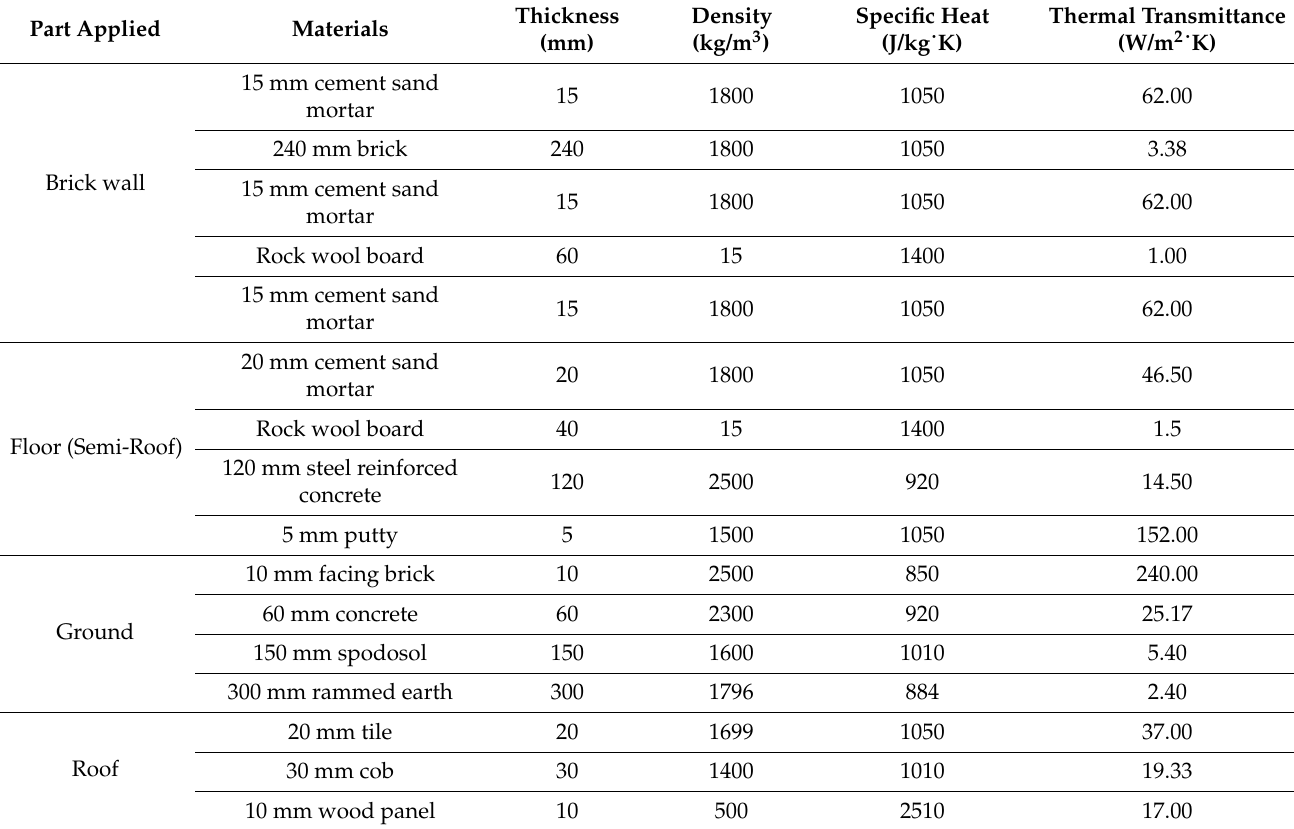
Table 7. Materials and their thermal coefficients of the passive design rural